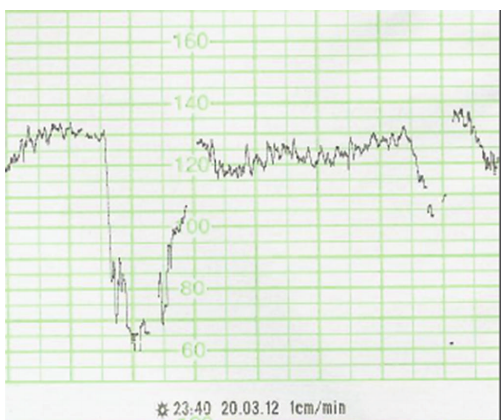
Figure 1: Fetal heart rate pattern showing variable deceleration with no acceleration (VDna).